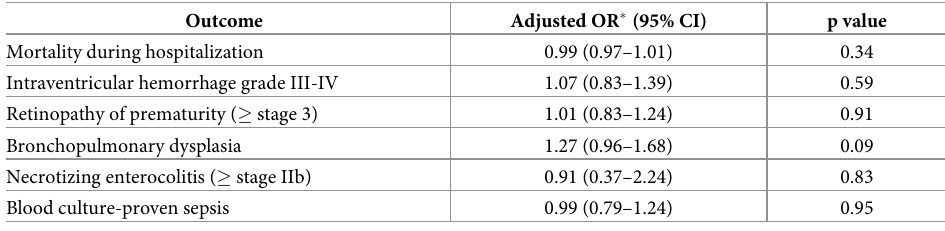
Table 3. Adjusted odds ratios for risk of adverse outcomes by duration (per week) of HS